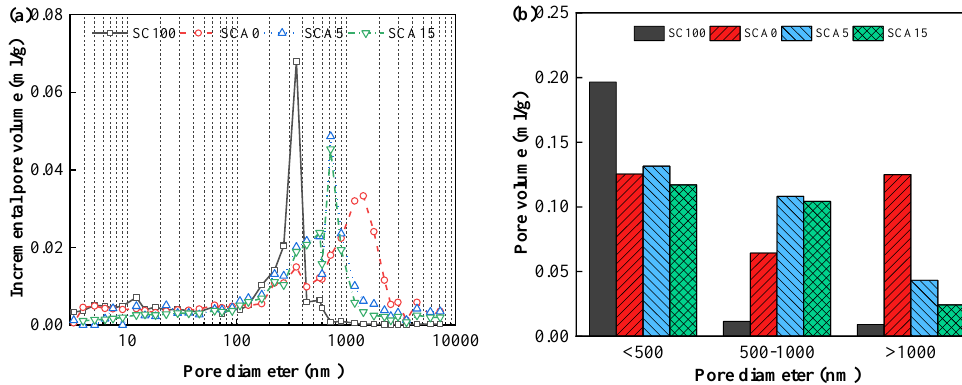
Figure 6. Pore size distribution results of hardened CPB with different doses of C Ṡ A at the hydration time of 28 days: ( a ) the incremental pore volume, and ( b ) the volume of different pore types.